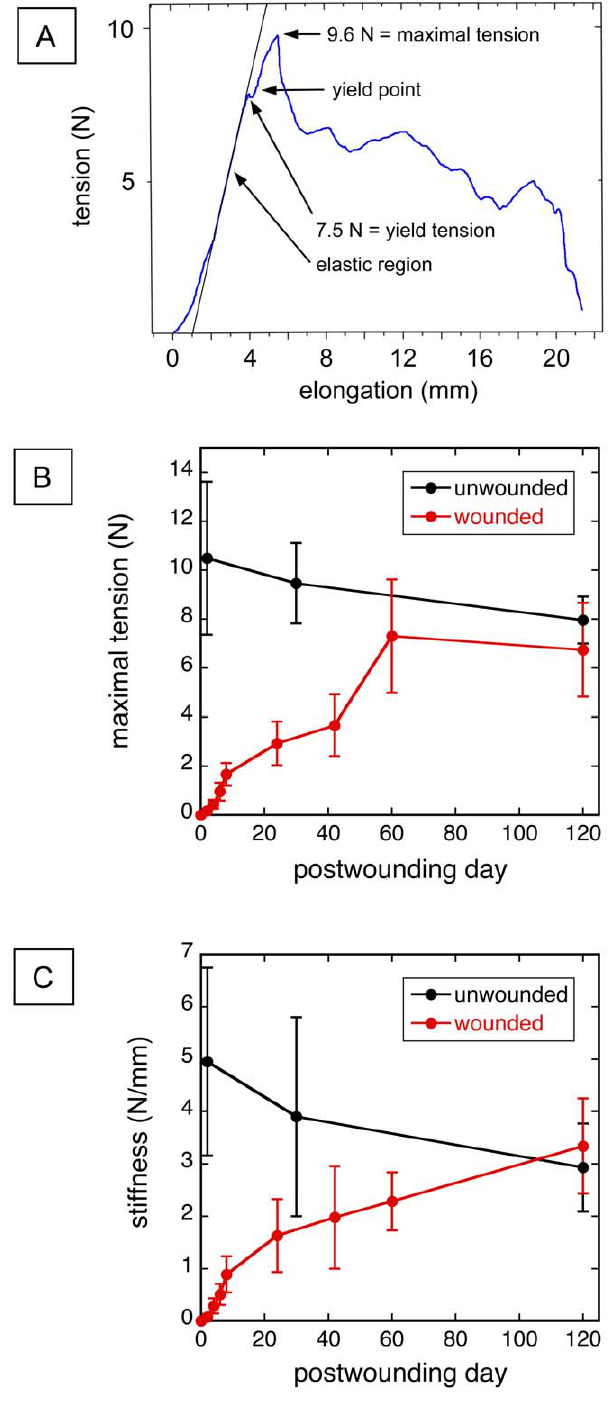
Figure 2. Tensile properties of wounded vs. unwounded abdominal wall. (A) Typical plot of tensile force vs. elongation in the disruption of a single test strip (blue curve) generated during tension testing of a test strip from uninjured abdominal wall loaded, at the elongation rate of 2 mm/min. The black straight line is the calculated slope of the curve in the elastic region. (B) Maximal tension sustained by tissue test strips vs. postwounding day (PWD) of the injured mouse abdominal wall compared with maximal tension vs. age of uninjured abdominal wall from age-matched control mice. Each data point represents the mean maximal tension ( 6 SD) of 14–24 test strips. (C) Tensile stiffness vs. PWD for the same specimens as in panel B. Tensile stiffness was calculated as the slope of the straight line in